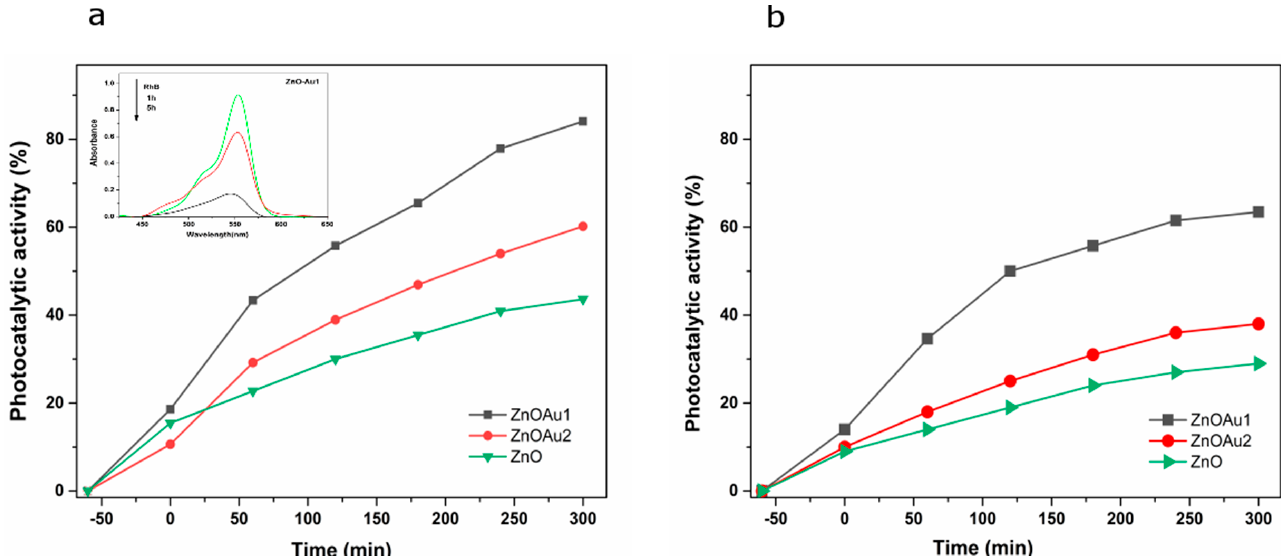
Figure 11. Photocatalytic degradation of ( a ) RhB and ( b ) OTC in the presence of ZnO nanoparticles: respectively, ZnO-Au1 and ZnO-Au2 nanocomposites. The inset in ( a ) represents the UV-vis absorption spectra of RhB aqueous solution in the presence of ZnO-Au1 at different irradiation time intervals.